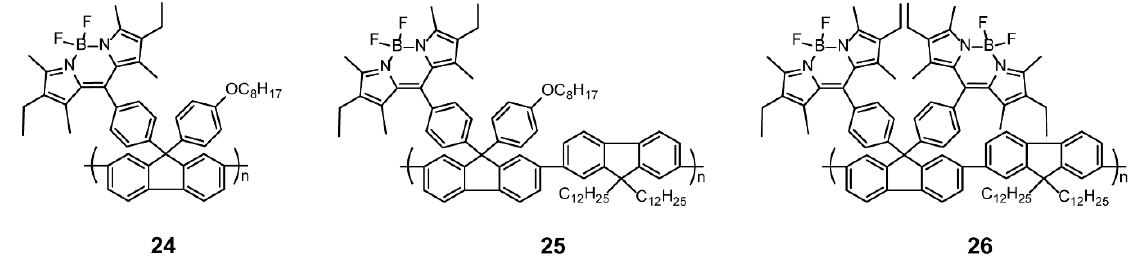
Figure 8. Chemical structures of polymers 24 – 26 (Reproduced with permission from Reference [54]. Copyright @ 2013, American Chemical Society).